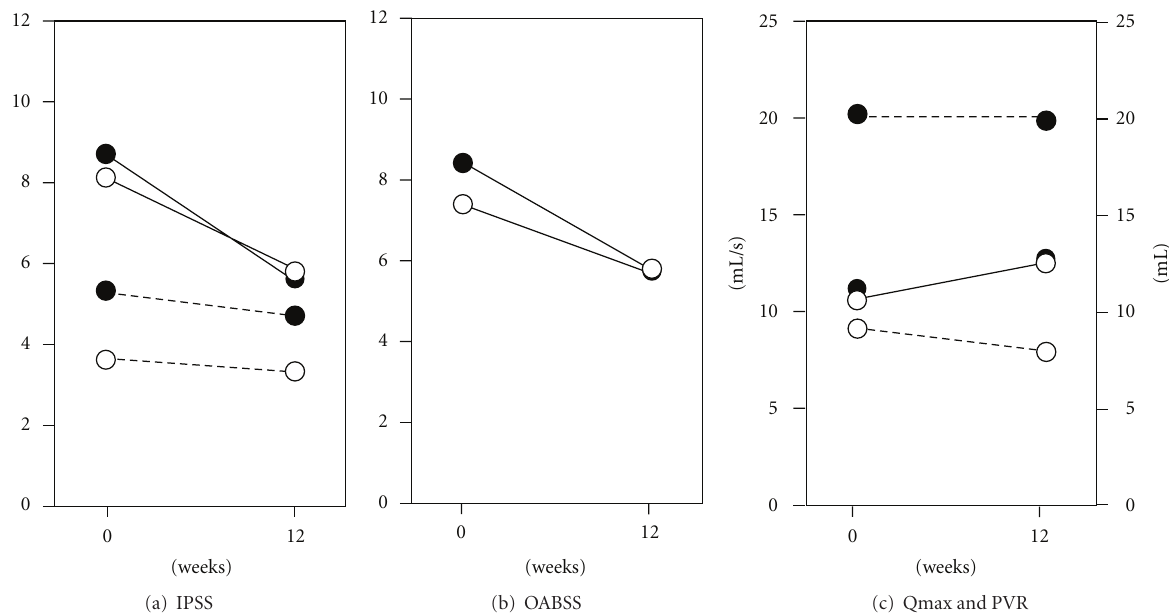
Figure 1: Changes in parameters before and after 2.5 mg and 5.0 mg of solifenacin treatment. White and black circles indicated mean value of 2.5mg and 5.0 mg of solifenacin, respectively. (a) The IPSS storage symptoms (line) and the IPSS voiding symptoms (dotted lines) 2.5mg: n = 16, 5.0mg: n = 32, (b) OABSS, 2.5 mg: n = 16, 5.0 mg: n = 32, and (c) Qmax (line, 2.5 mg: n = 12, 5.0 mg: n = 24) and PVR (dotted lines, 2.5 mg: n = 15, 5.0 mg: n = 30).